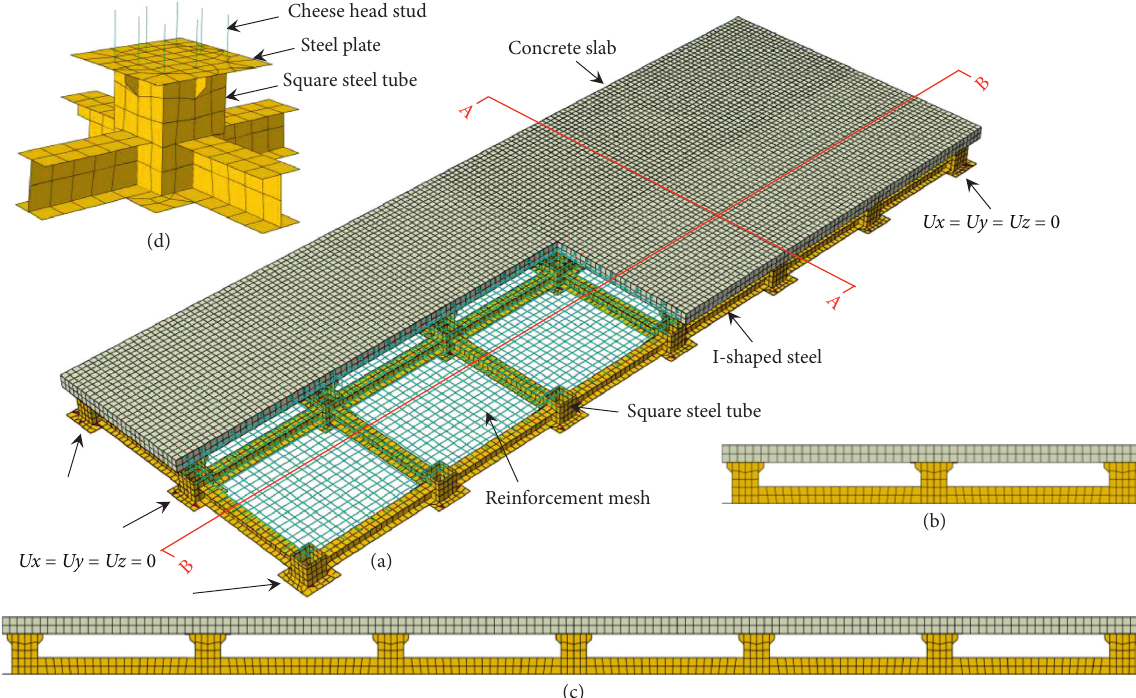
Figure 9: FE meshes of the COF system. (a) Meshed FE model. (b) A-A section. (c) B-B section. (d) Details of joint.